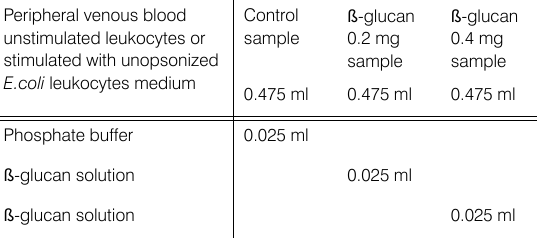
Table 1. Analysis scheme Peripheral venous blood unstimulated leukocytes